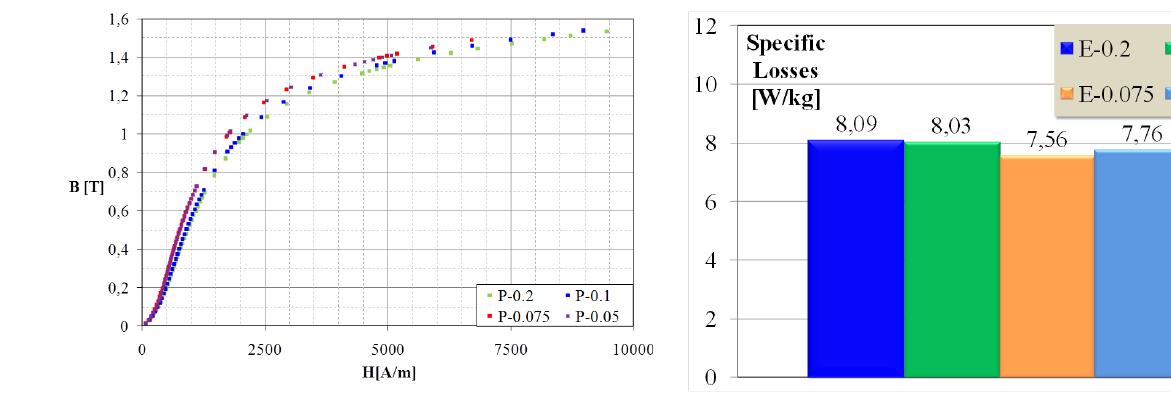
Figure 4: Specific iron losses for 50Hz @ 1T of epoxy samples